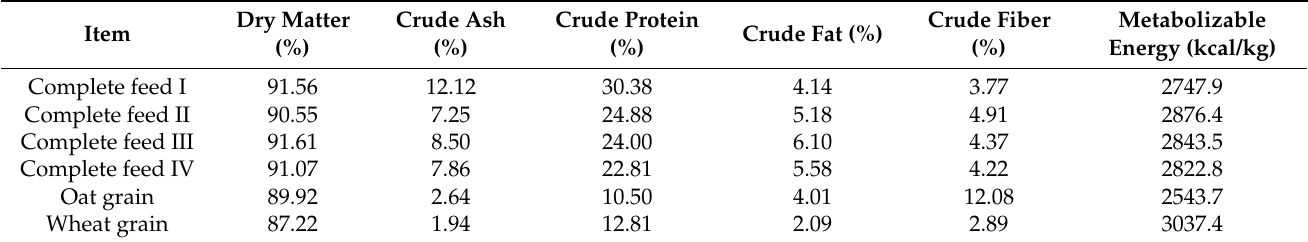
Table 2. Chemical composition and metabolizable energy of the feed and grains used throughout the rearing period of organic